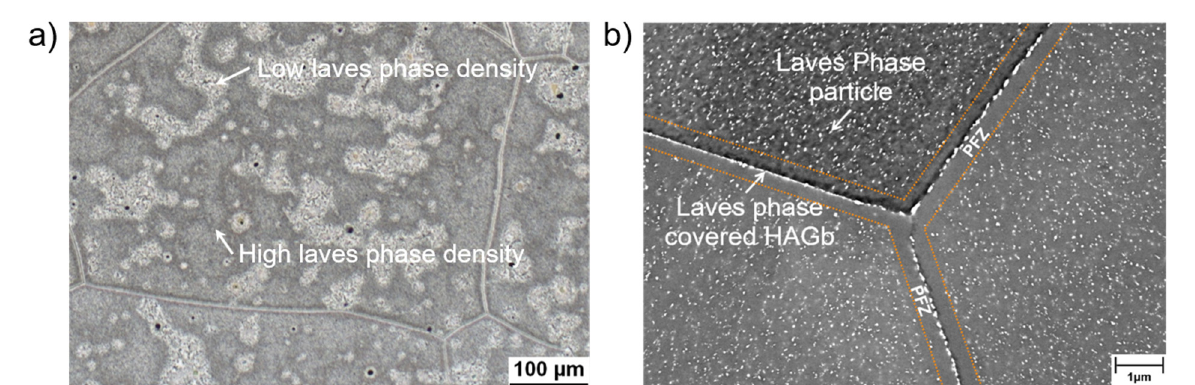
Figure 2. Characteristic microstructure of recrystallized and precipitation-annealed (RX + PA) fully ferritic Crofer ® 22 H steel. ( a ) Light optical resolution: Inhomogeneous Laves phase precipitate density (light areas: low density; dark areas: high density), caused by primary Ti/Nb-MX precipitates (reproduced from [30]). ( b ) SEM resolution: Particle-free zones (PFZ) located at high-angle grain boundaries (HAGB, reproduced from [11]).